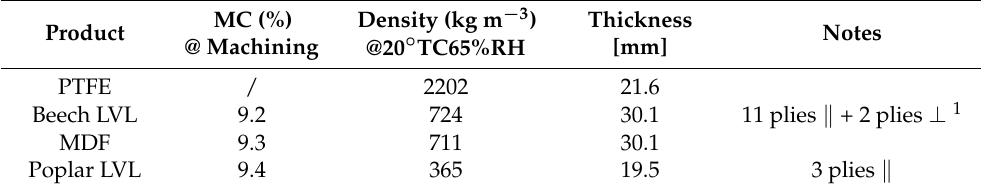
Table 1. Machined material thicknesses and physical properties. Moisture content before machining was determined by the gravimetric method; the density of the machined samples was determined after equilibration at 20 ◦ C and 65% relative humidity